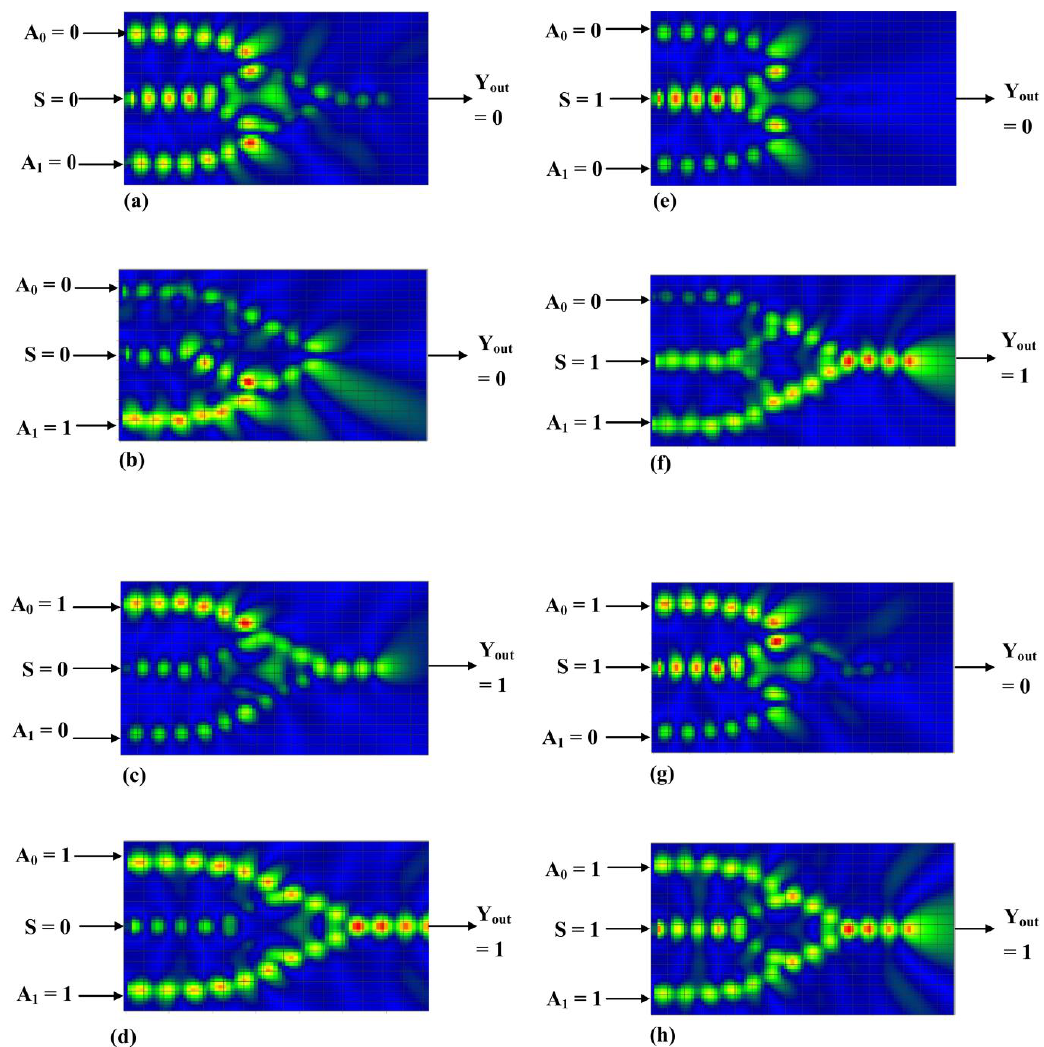
Figure 2. ( a – h ). Propagation of light through the 2 × 1 multiplexer for various conditions of control signal(S) and inputs A 0, A 1 using opti-FDTD method.